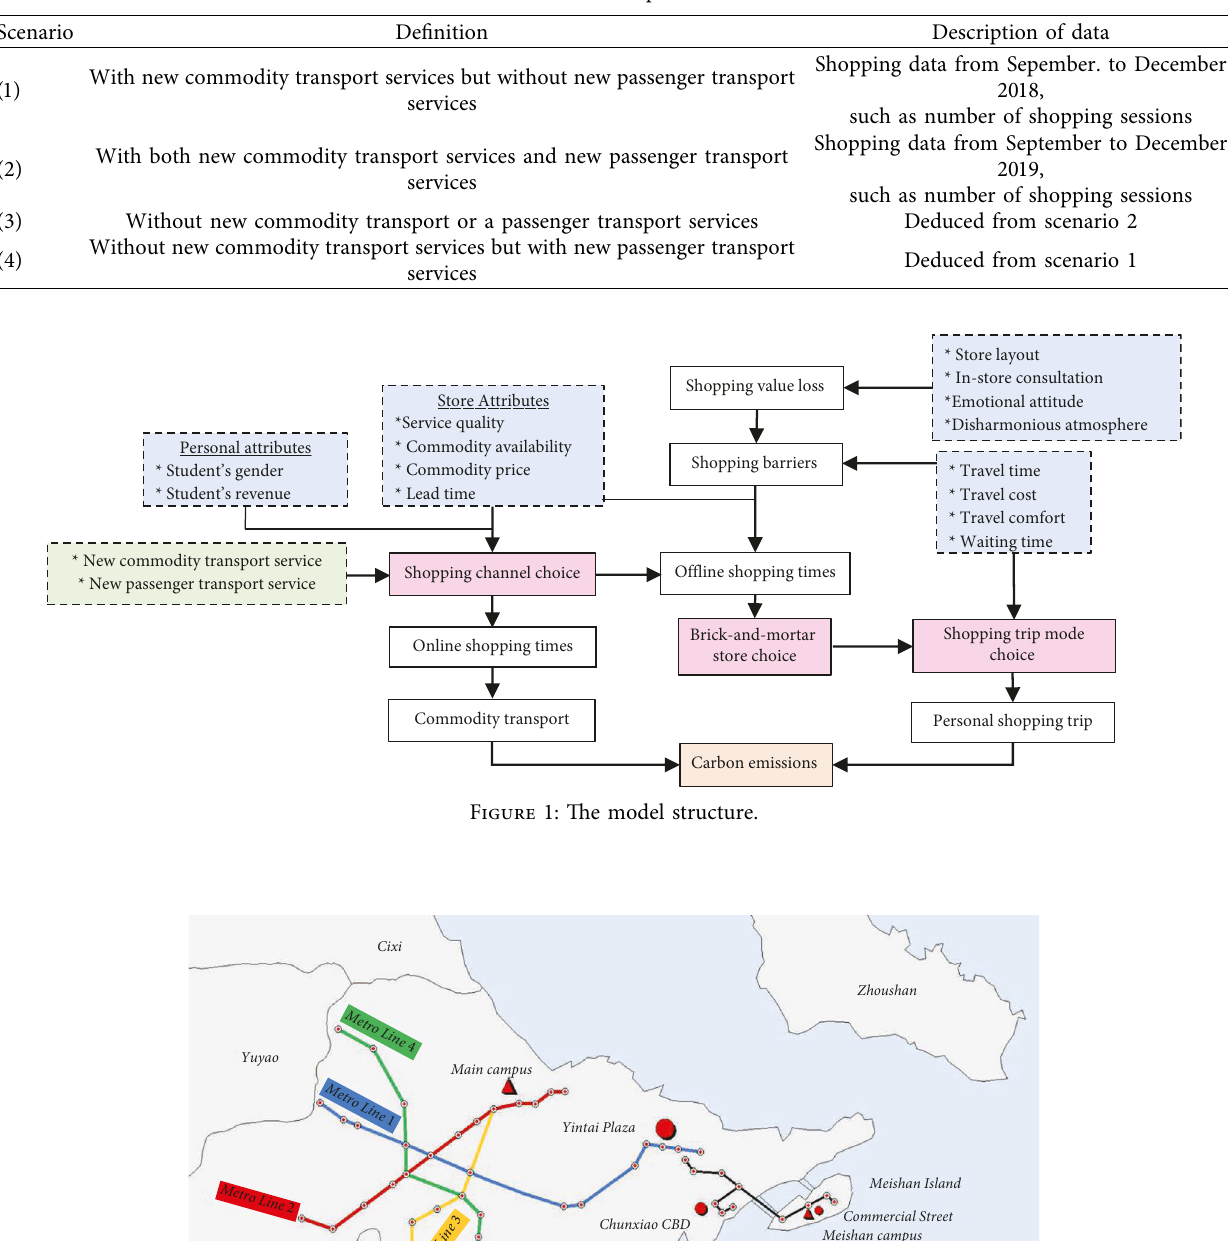
Table 1: Definition of each scenario and description of the data used for each scenario.